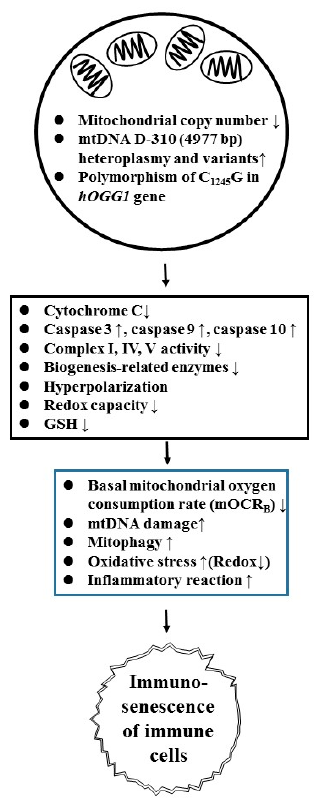
Figure 2. The molecular bases of mitochondrial dysfunction in inducing immune cell senescence in patients with SLE. mt: Mitochondrial; hOGG1 : Gene encoding human 8-oxoguanine DNA N-glycosylase 1; Redox: Reduction and oxidation.